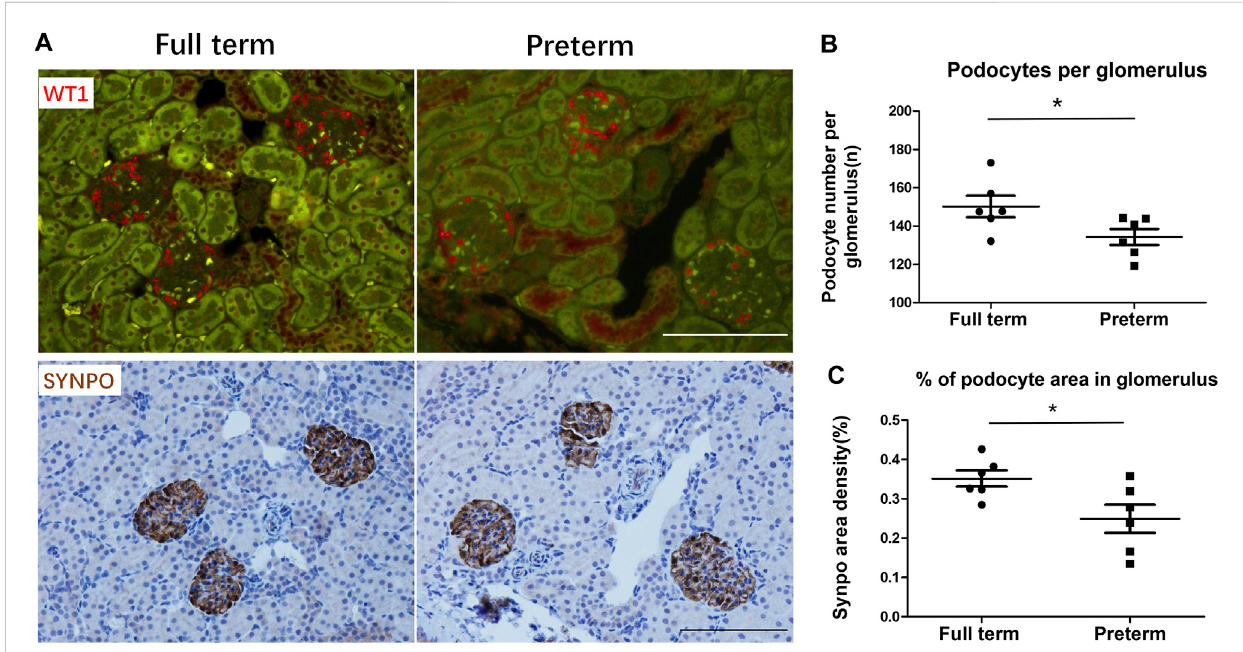
FIGURE 1 Preterm birth causes areductionin thenumberofdifferentiated podocytes (PDs)at3 weeks postnatally (A) Theupperpanelsshow WT1-stained PD nuclei (red). The lower panels show SYNPO peroxidase-stained PD cell bodies (brown) in the same sections. The left panels show full-term rat glomeruli. The right panels show preterm rat glomeruli. Bar = 100 µm. (B,C) At 3 weeks postnatally, PDs have already fi nished differentiating. The podometric parametersofPDnucleiperglomerulusandpercentageofPDareaintheglomerulusshowedthatcomparedwithfull-termrats(n=6),pretermrats (n = 6) had signi fi cantly decreased PD numbers ( p < 0.05) and PD area ( p < 0.05). (T tests were used to compare parameters between full-term and preterm rats, *: p <